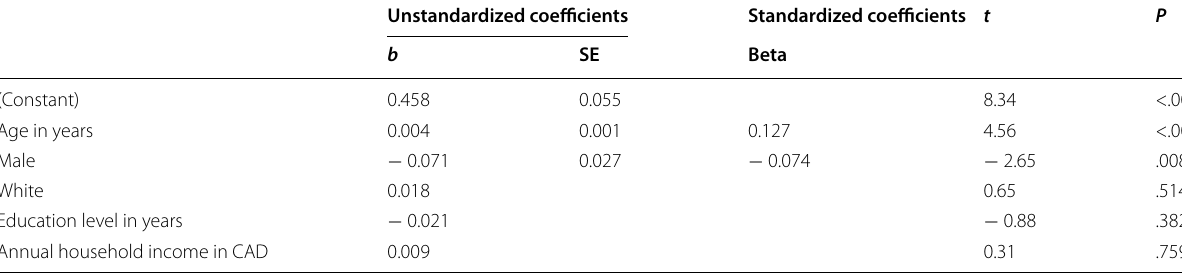
Data include the entire sample. Values are results for logistic regression. The unstandardized coefficient represents the amount of change in the dependent variable due to a change of 1 unit of the independent variable. Standardized coefficients are normalized unit-less coefficients indicating effects strength. White race, education level, and income were not uniquely significant predictors of disclosure of